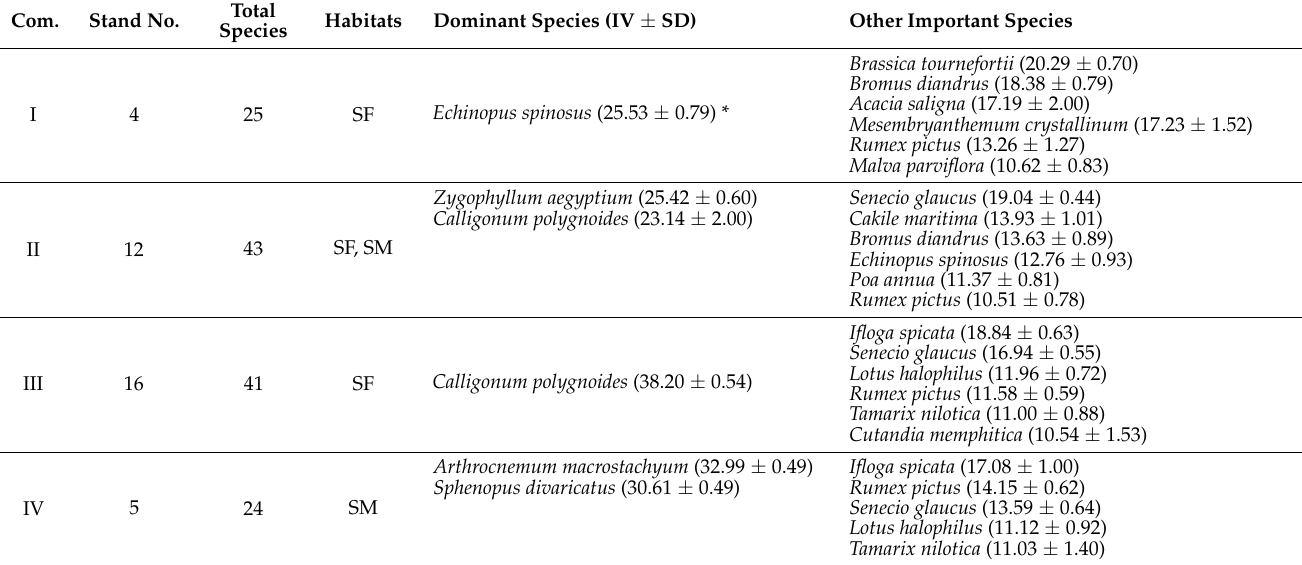
Table 2. Characteristics of the different communities (I–IV) from TWINSPAN classification of the studied area.